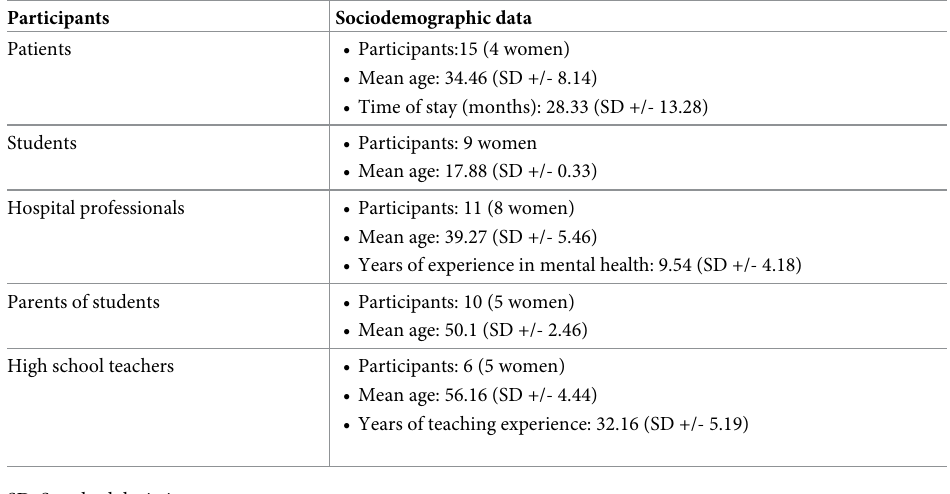
Table 1. Sociodemographic data of